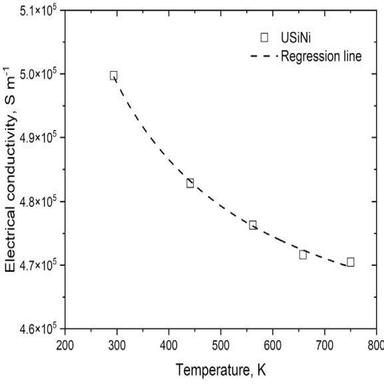
Electrical conductivity of annealed USiNi sample measured by the fourpoint method.